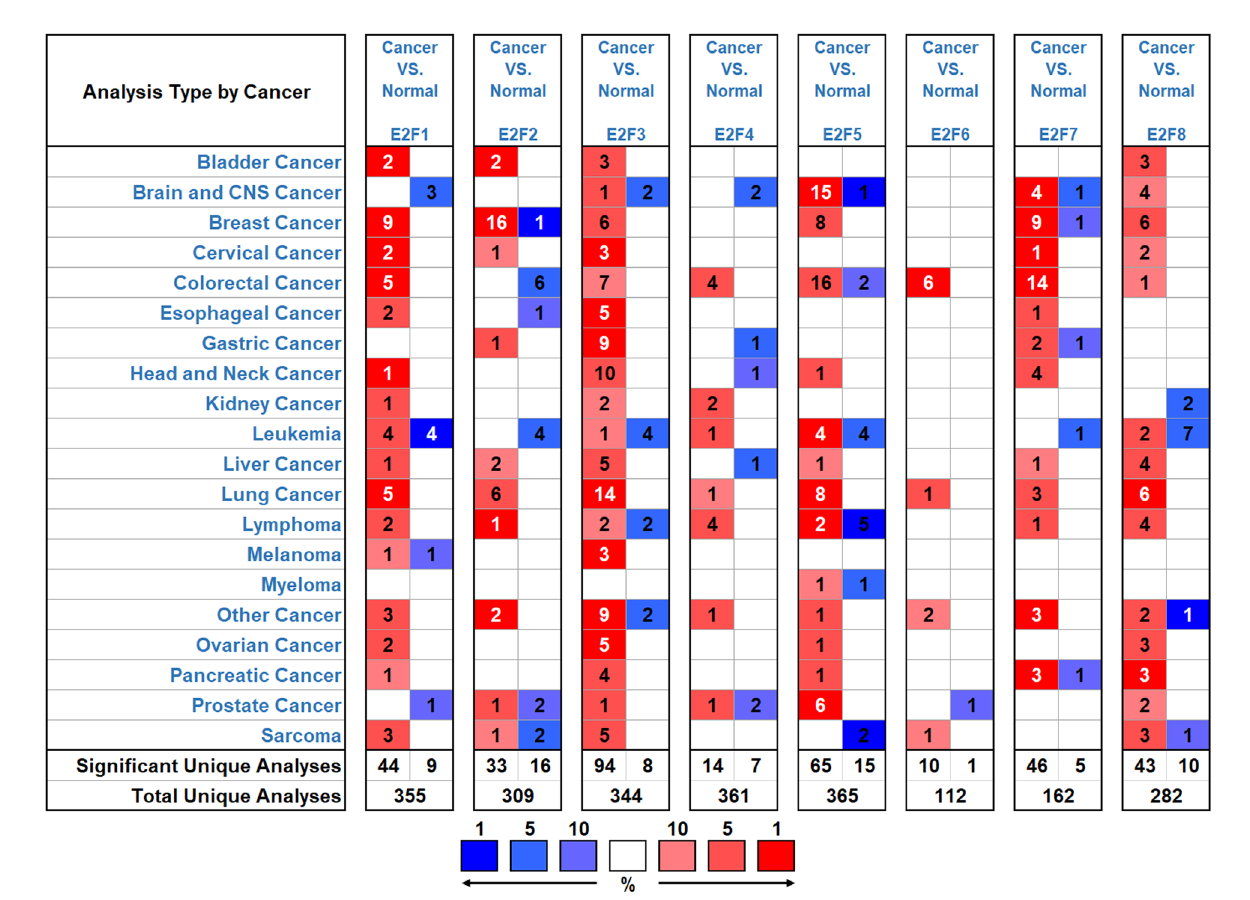
FIGURE 1 | The transcription levels of E2F factors in different types of cancers (Oncomine). The panel shows the numbers of datasets with statistically signi fi cant mRNA over-expression (red) or downregulated expression (blue) of E2F factors. The threshold was designed with the following parameters: fold change of 1.5 and P -value of 0.05.